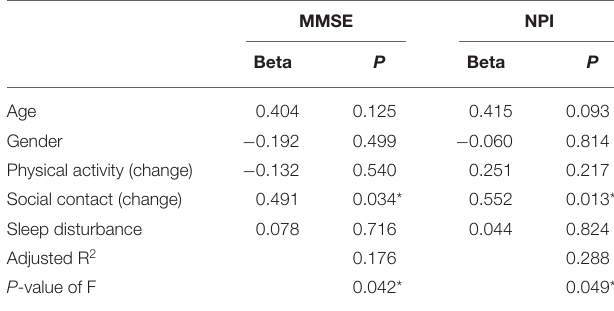
TABLE 5 | Multiple linear regression analysis of cognitive and neuropsychiatry changes in dementia with Lewy